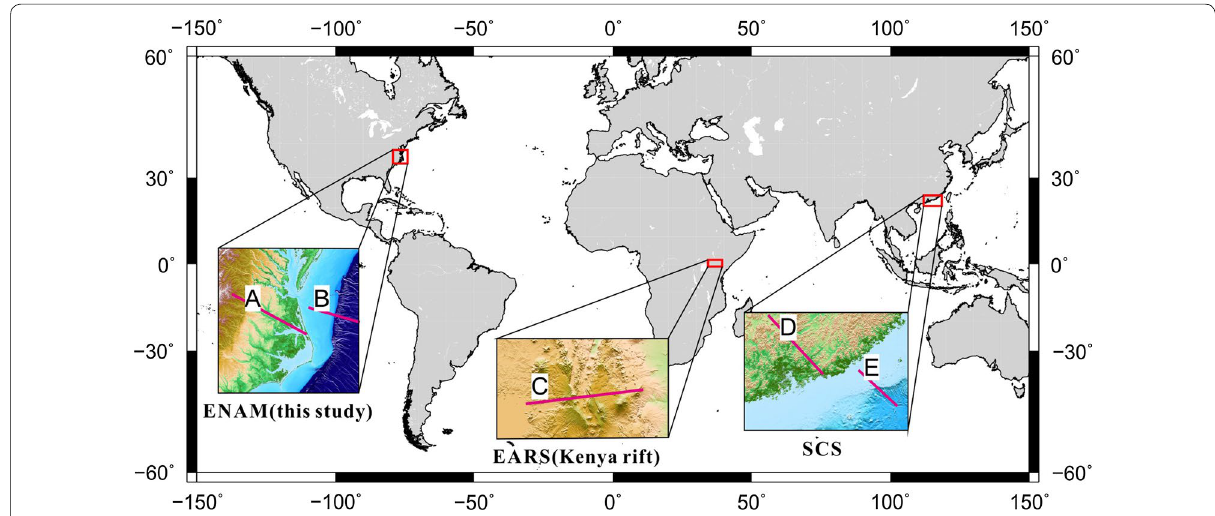
Fig. 16 Location map for rifted margins compared in this study. The pink lines in the figure indicate the wide-angle seismic profiles used to infer the crustal structure: A, this study; B, Holbrook et al. (1994); C, Maguire et al. (1994); D, Zhang et al. (2013); Wan et al.